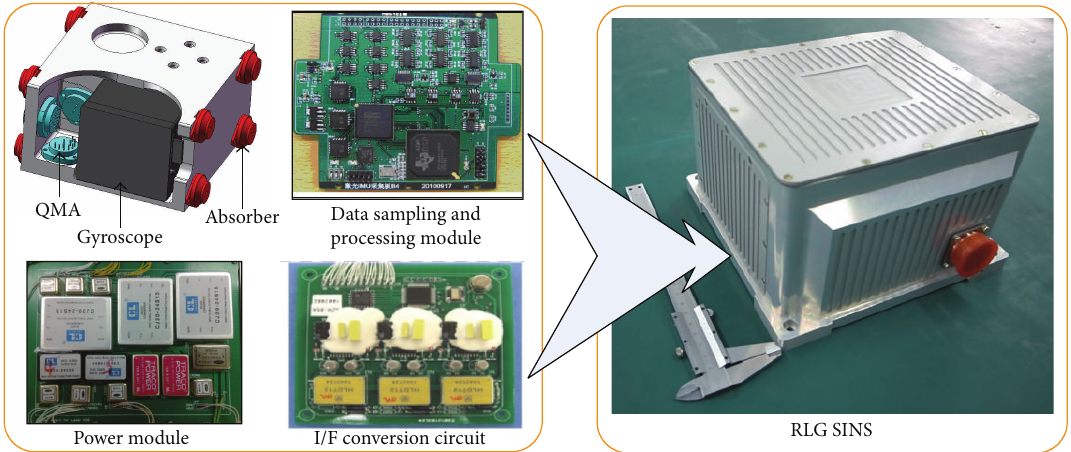
Figure 2: The hardware components and operation principle of RLG POS.